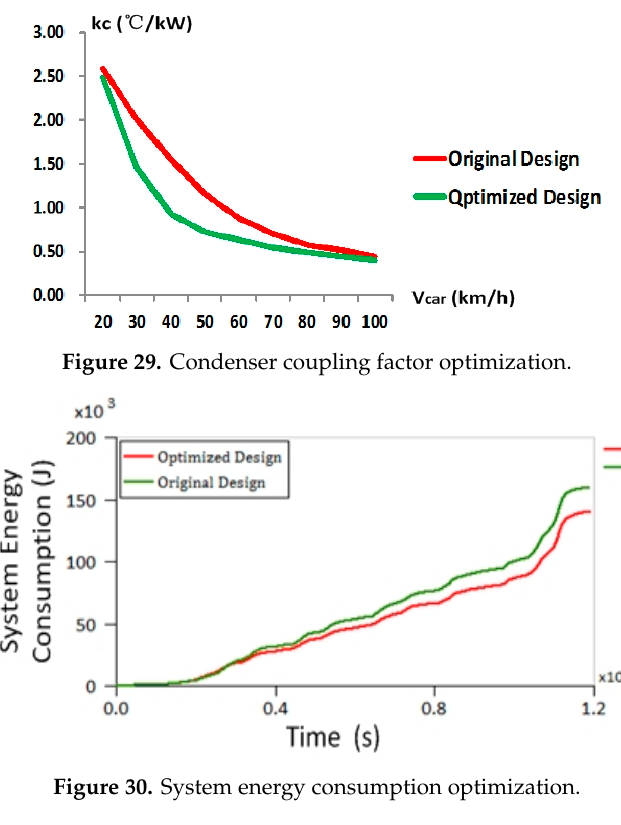
Figure 28. Radiator coupling factor optimization.